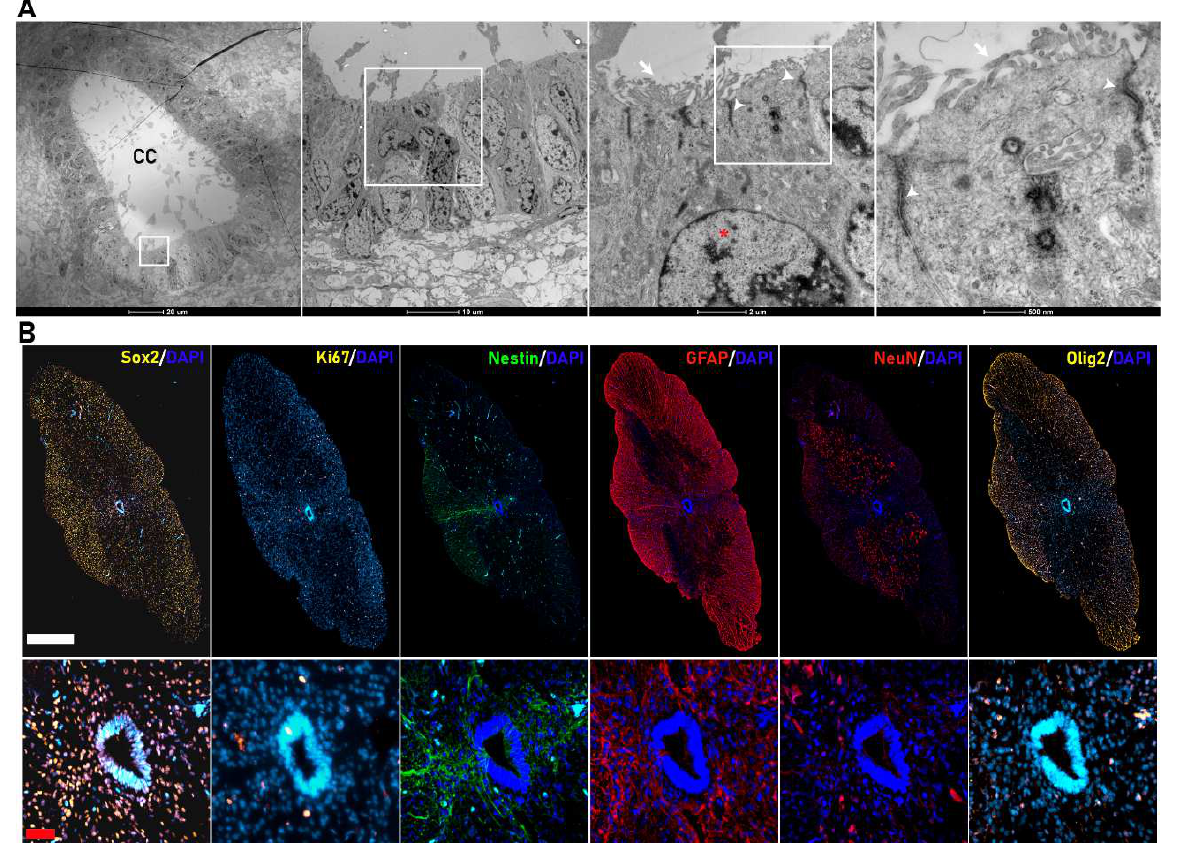
Figure 1. Cytoarchitecture of the human fetal spinal cord. ( A ) Transmission electron microscopy (TEM) images of the central canal of the human fetal spinal cord (scale bar (from left to right) = 20 µ m, 10 µ m, 2 µ m, and 500 nm). The central canal is formed by ependymal cells organized as a pseu- dostratified epithelium with a large number of cilia in the apical zone (white arrow), nuclei with condensed chromatin (*), and large apical junction complexes (white arrowheads). ( B ) Representative coronal immunostaining images (complete coronal sections in upper panels and magnified view of the corresponding CC area in the lower panels) of human fetal spinal cords for SOX2 (yellow), Ki67 (yellow), Nestin (green), Gfap (red) , NeuN (red), and Olig2 (yellow) (white bar scale= 500 µ m; red bar scale = 50 µ